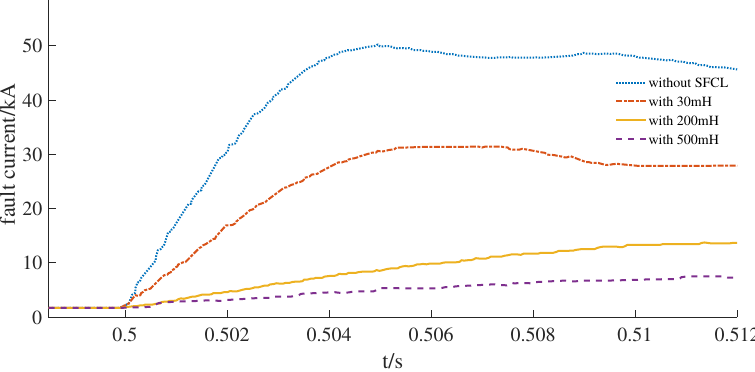
Figure 15. Short circuit current with the improved inductive Fig. 2. The working principle of the improved inductive SFCL.